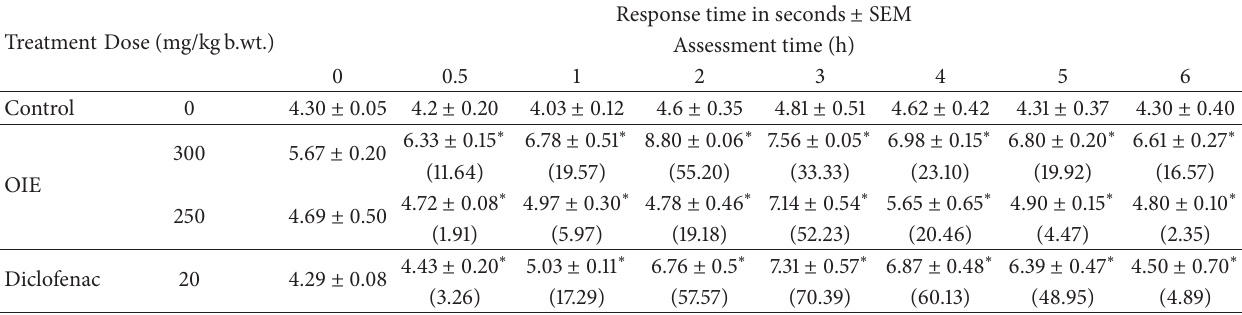
Table 3: Alteration in the response time in mice treated with Oroxylum indicum before subjecting them to tail immersion test. Treatment Dose (mg/kgb.wt.)